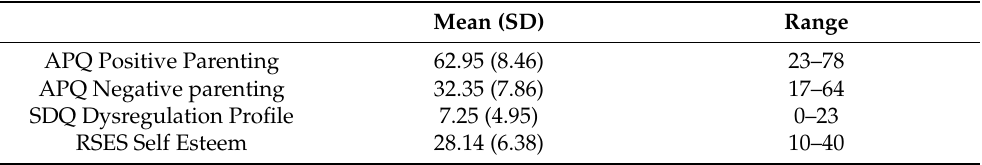
Table 1. Descriptive statistics (means, standard deviations and range) of the parent and adolescent reported